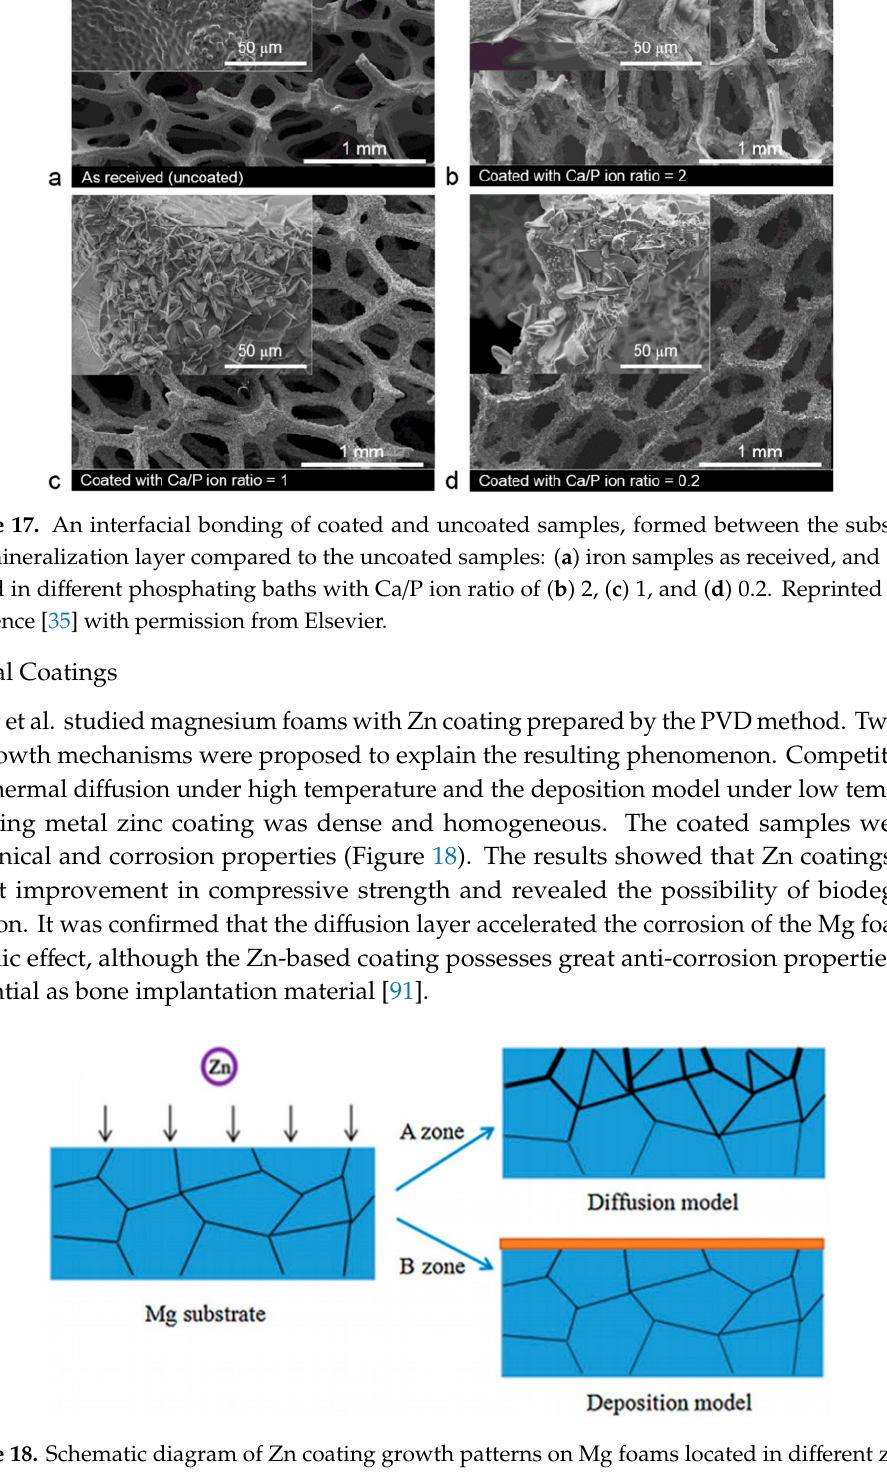
Figure 18. Schematic diagram of Zn coating growth patterns on Mg foams located in different zones. Reprinted from Reference [91] with permission from Elsevier .